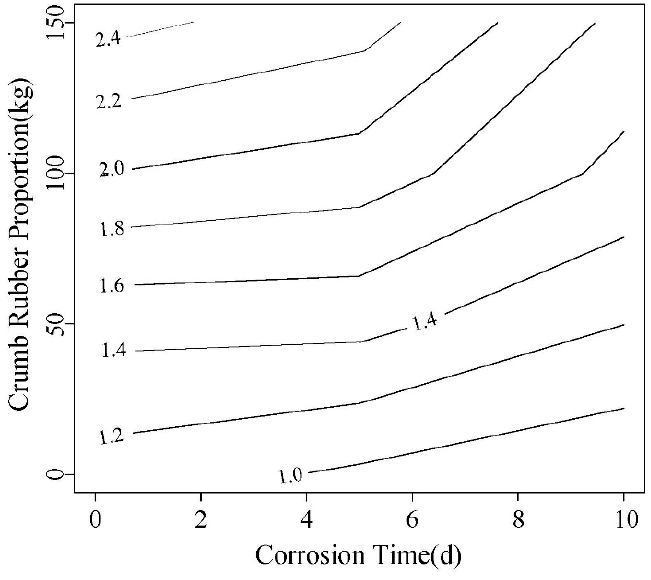
Figure 17. Equipotential line diagram of unit energy consumption corresponding to 2.5 mm displacement at mid-span of 0.45 water-cement ratio.